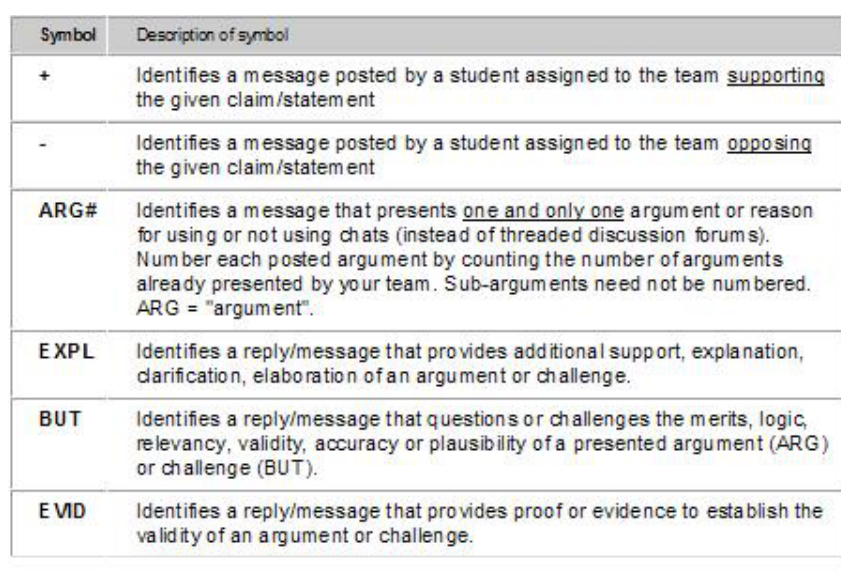
Figure 1. Example instructions on how to label messages during the online debates